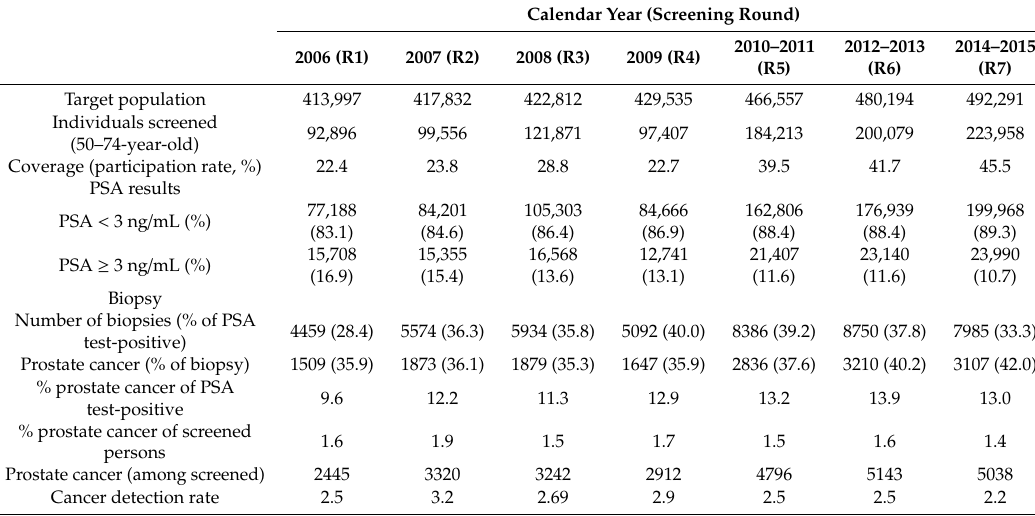
Table 1. Main performance indicators of of Early Prostate Cancer Detection Programme (EPCDP) in Lithuania in the first seven screening rounds between 2006 and 2015.